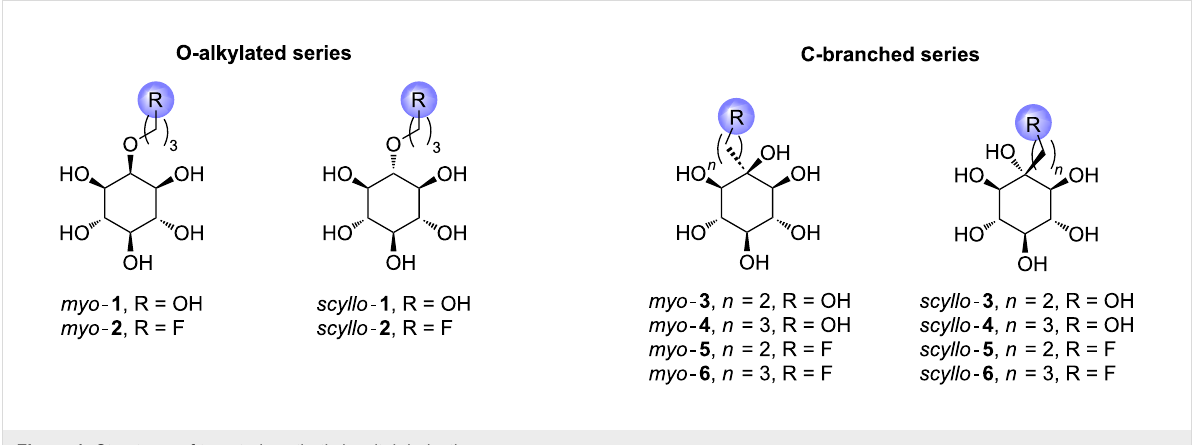
Figure 1: Structures of targeted synthetic inositol